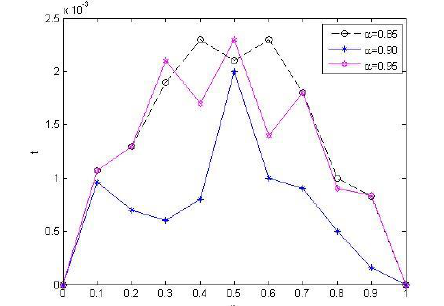
Figure 4. Absolute errors for various values of 